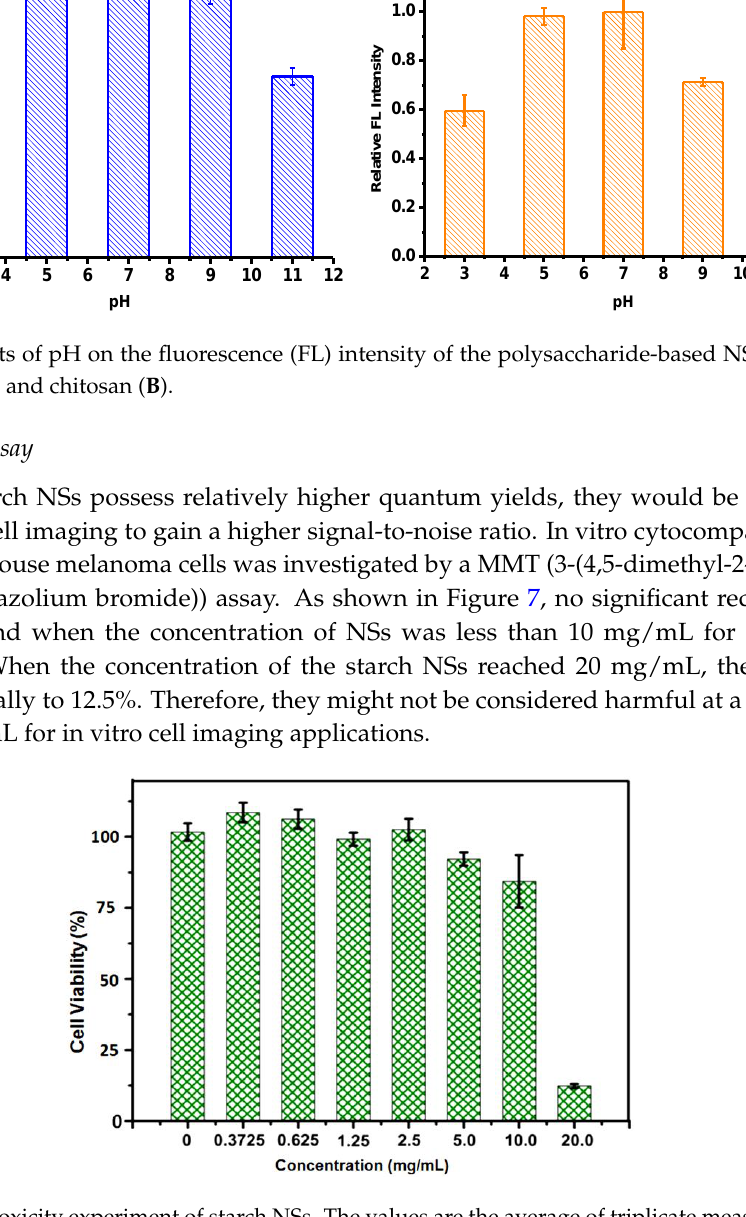
Figure 5. Effect of metal ions on the fluorescence (FL) intensity of the polysaccharide-based NSs prepared from starch ( A ) and chitosan ( B ).